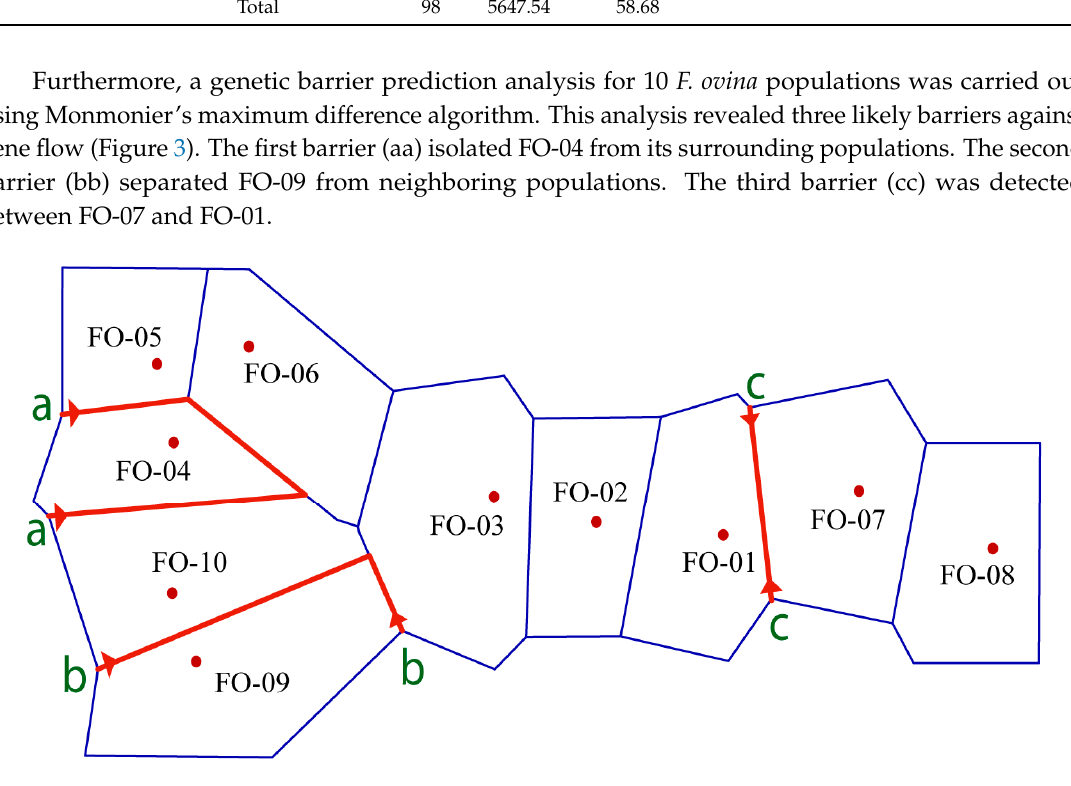
Figure 3. Genetic barriers predicted by BARRIER software (version 2.2, Syracuse University, New York, NY, USA). Lines a, b, and c indicated genetic barriers.